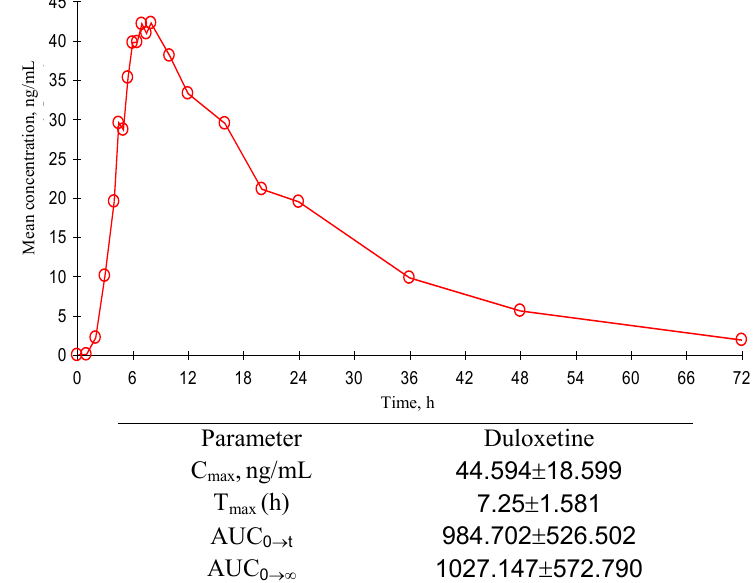
Figure 4. Mean plasma concentration-time profile of Duloxetine Hydrochloride 60 mg Delayed Release Capsules formulation to 8 healthy